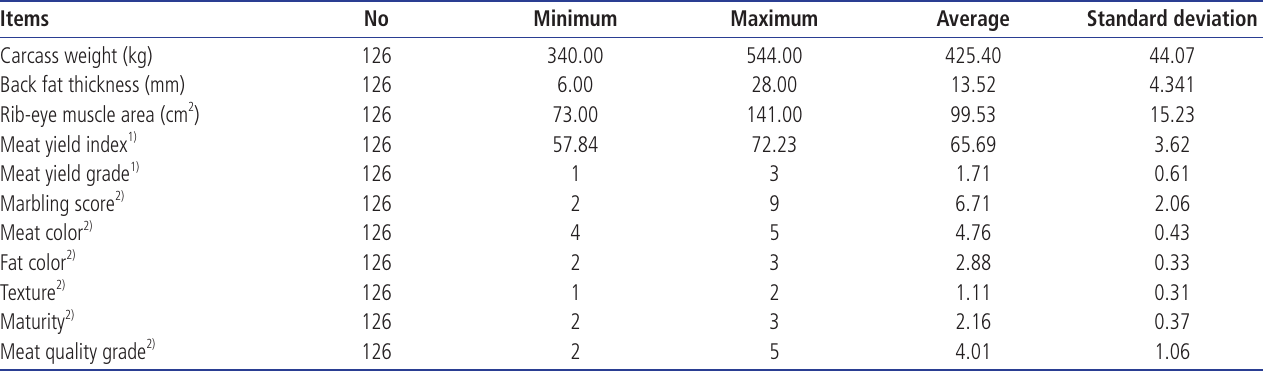
Table 2. Carcass traits of Hanwoo steers fed a formula feed and rice straw or total mixed rations until 30 months of age Items